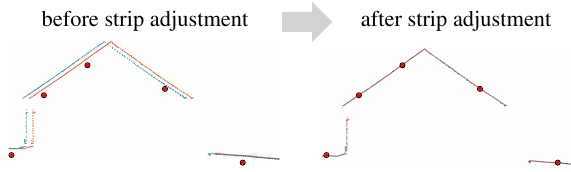
Figure 1: The discrepancies between overlapping strips (blue/orange) and between strips and ground control points (red) are minimized simultaneously by strip